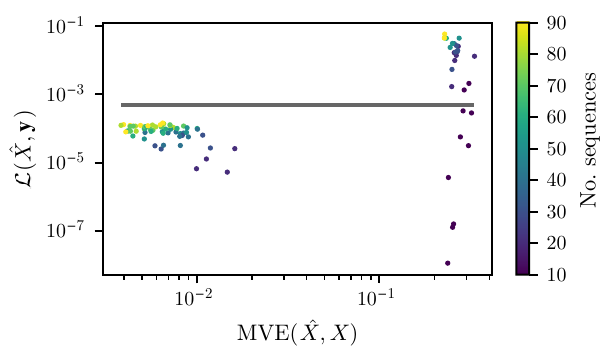
FIG. 5. Least-squares objective function versus MVE at the end of the mGST optimization, with the gray bar indicating the range of stopping values below which a run is considered suc- cessful. The plot illustrates that results with a large MVE also have a large objective function if enough sequences are mea- sured. The experiment is the same as in the top left of Fig. 3 for r K = 4. The color of each point indicates the number of measured sequences on which mGST is run.